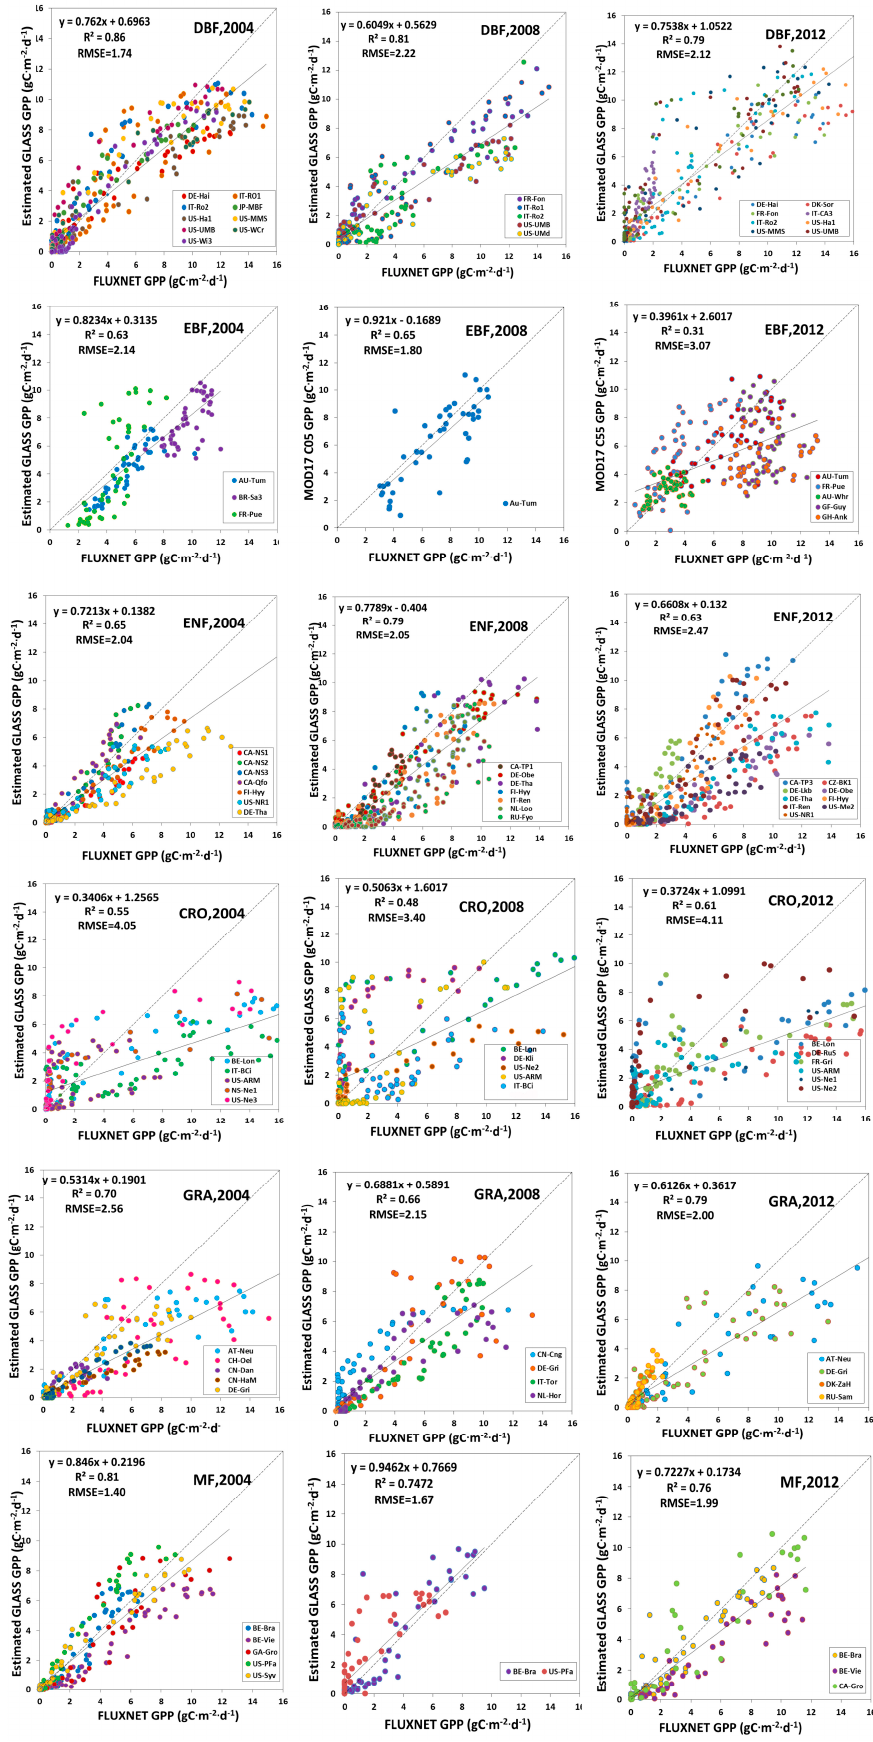
Figure 9. Validation of estimated GLASS GPP against FLUXNET GPP.